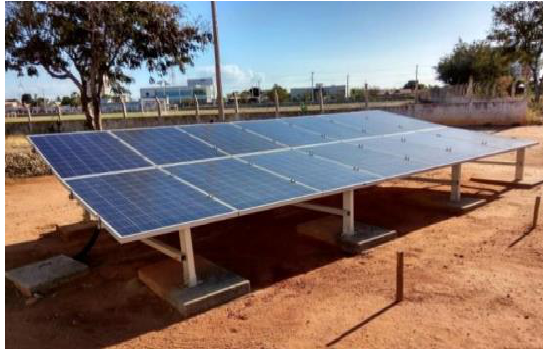
Figure 2. PV array.